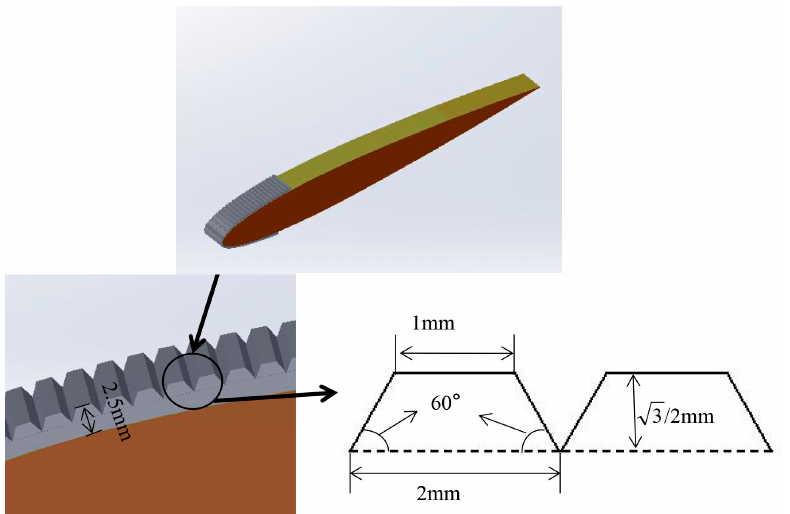
Figure 4. Bionic coating of V-type. Appl. Sci. 2020 , 10 , x